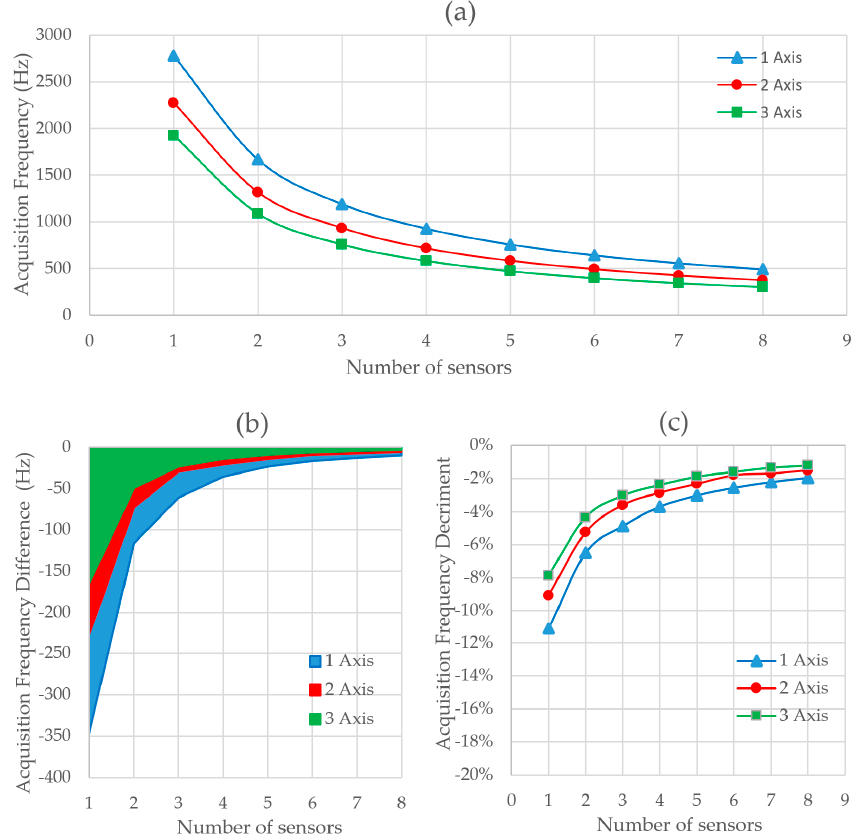
Figure 8. ( a ) Acquisition frequency depending on the number of sensors and axis read at the same time with data framing method, ( b ) total variation of the data acquisition frequency between Test 1 and Test 2, ( c ) percentage increase of the data acquisition frequency between Test 1 and Test 2, ( d ) acquisition frequency RSD depending on the number of sensors and axis read with data framing method, and ( e ) total error rate in Test